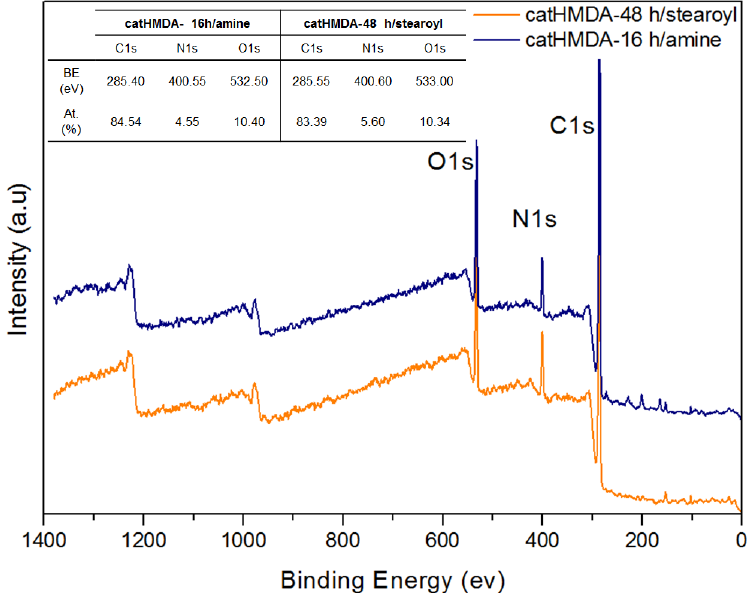
Figure 7. XPS spectra of the functionalized primer coatings deposited on a silicon substrate. The inset table shows their chemical composition. a.u.: Arbitrary units.